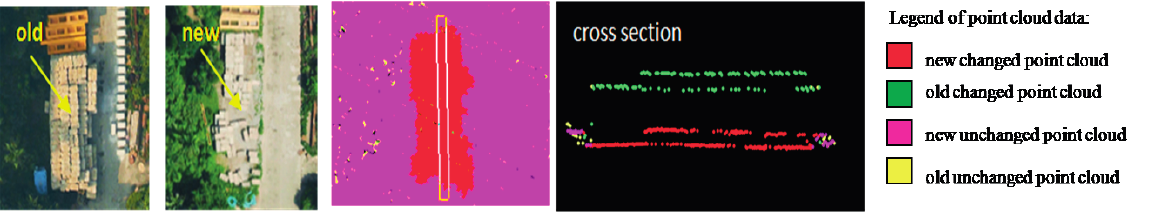
Figure 8. Details of building materials ( first column : old orthophoto; second column : new orthophoto; third column : superposition of the old and new point clouds; fourth column : cross-section of the yellow rectangle area in the third column; fifth column : legend of the point cloud